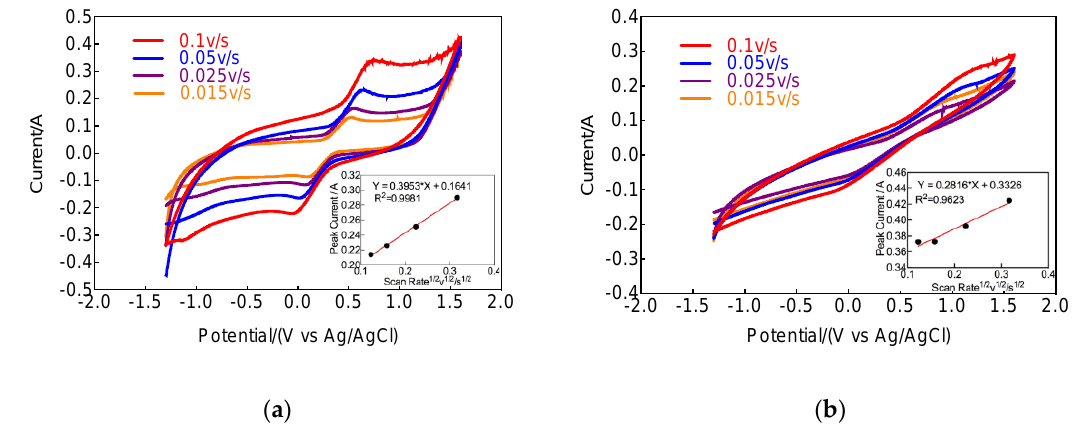
Figure 3. Cyclic voltammograms of the 3D and 2D electro-reactors in a 50 mmol/L K 4 Fe(CN) 6 + 0.45 mol/L Na 2 SO 4 solution at different scan rates. ( a ) 3D electro-reactor, ( b ) 2D electro-reactor. Insets show the plots of the peak current vs. the square root of the scan rate.